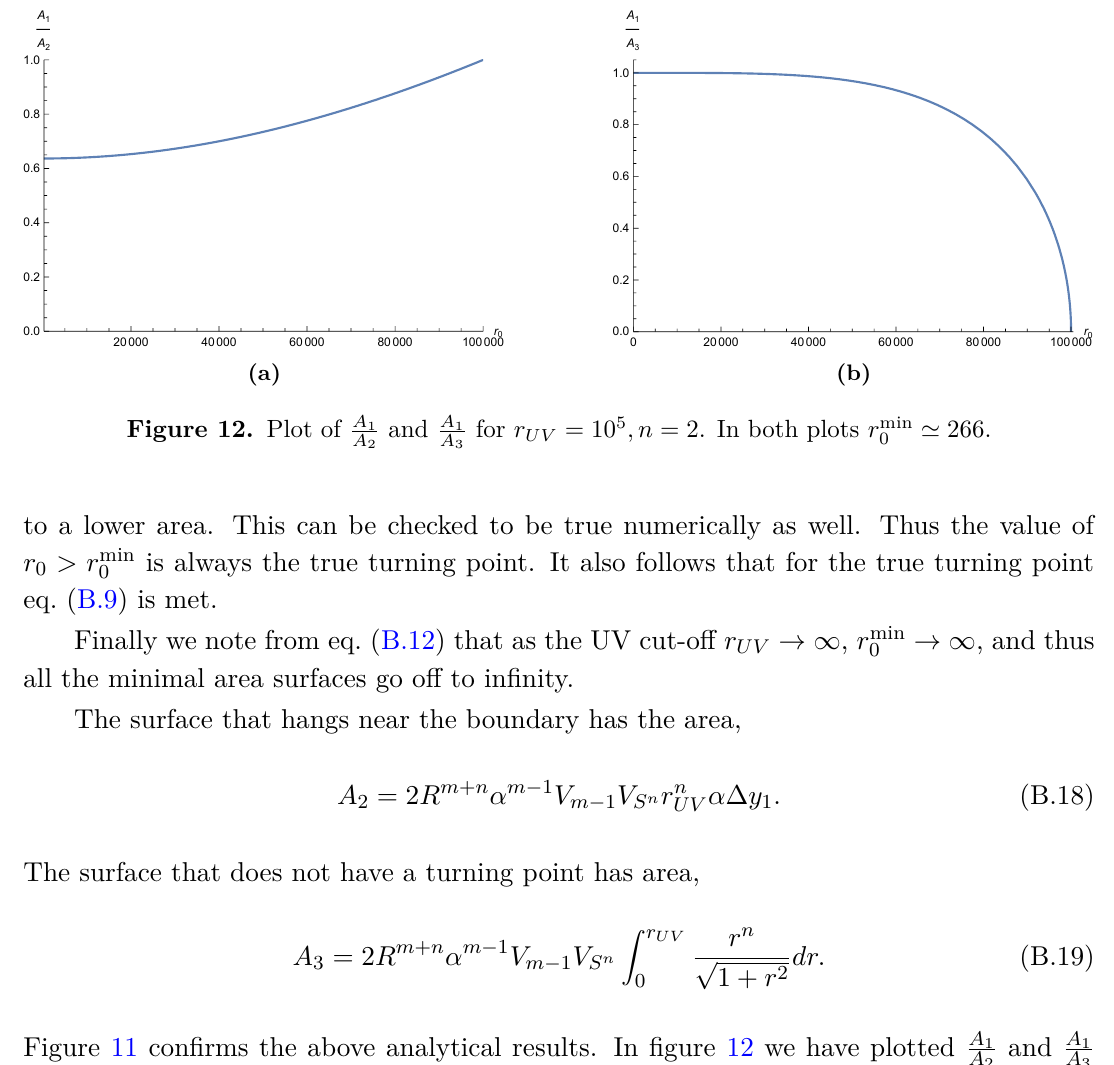
Figure 11. Plot of α ∆ y 1 vs r min . (a) For r UV = 10 5 , n = 2 , with r min 0 10 6 , n = 2 , with r min ' 841 . The plot also shows the two values of α ∆ y max 0